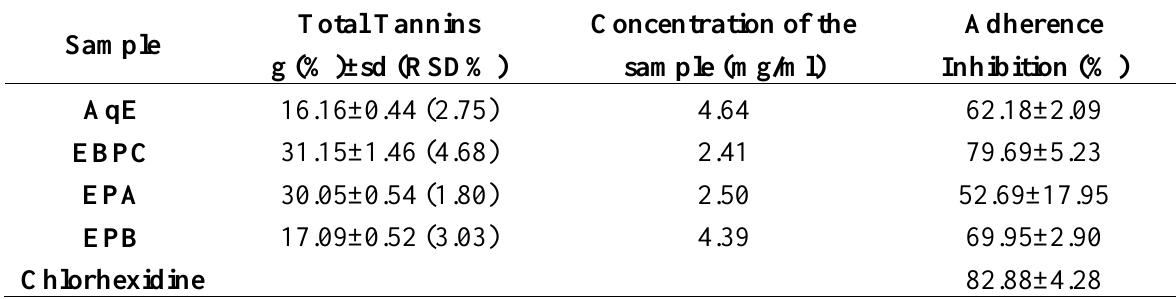
Table 2. Total tannins content, concentration of sample evaluated, and inhibition of bacterial adherence on a smooth surface.